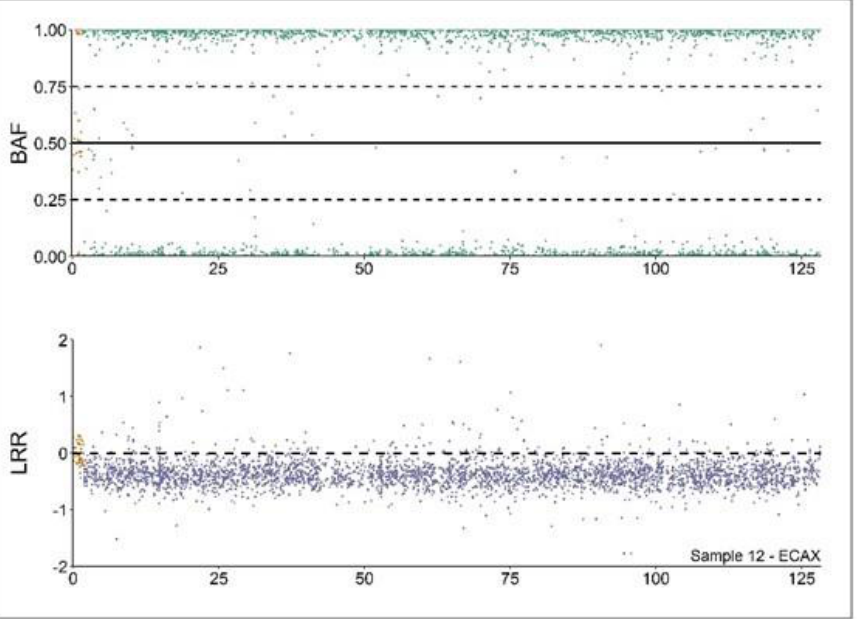
Figure 1. Copy number alterations (CNA) analysis profile of a 64,XY DSD mare . Analysis of the B allele frequency (BAF) and Log R ratio (LRR) values from a 64,XY DSD individual according to [10]. BAF values (upper part) depicting hemizygous markers (close to 0 or 1) in the non-pseudoautosomal region (XPAR, green). Conversely, the XPAR (in yellow) is mostly heterozygous (values close to 0.5). LRR values (lower part) are close to 0 in XPAR (in yellow), depicting diploidy. On the contrary, values in the non-XPAR region (in purple) are close to − 0.5, depicting